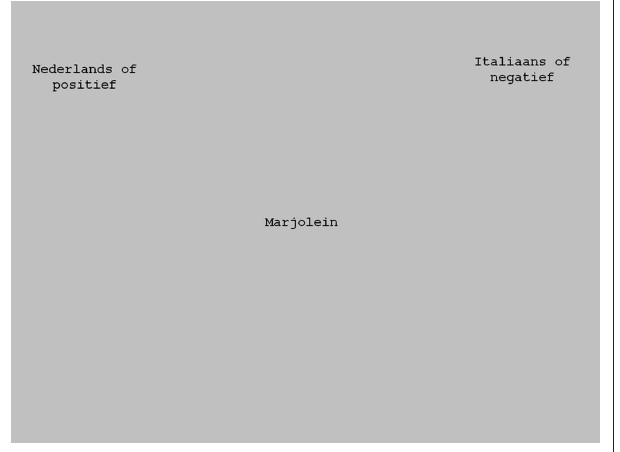
Table A1 | The stimuli words used in the iAT